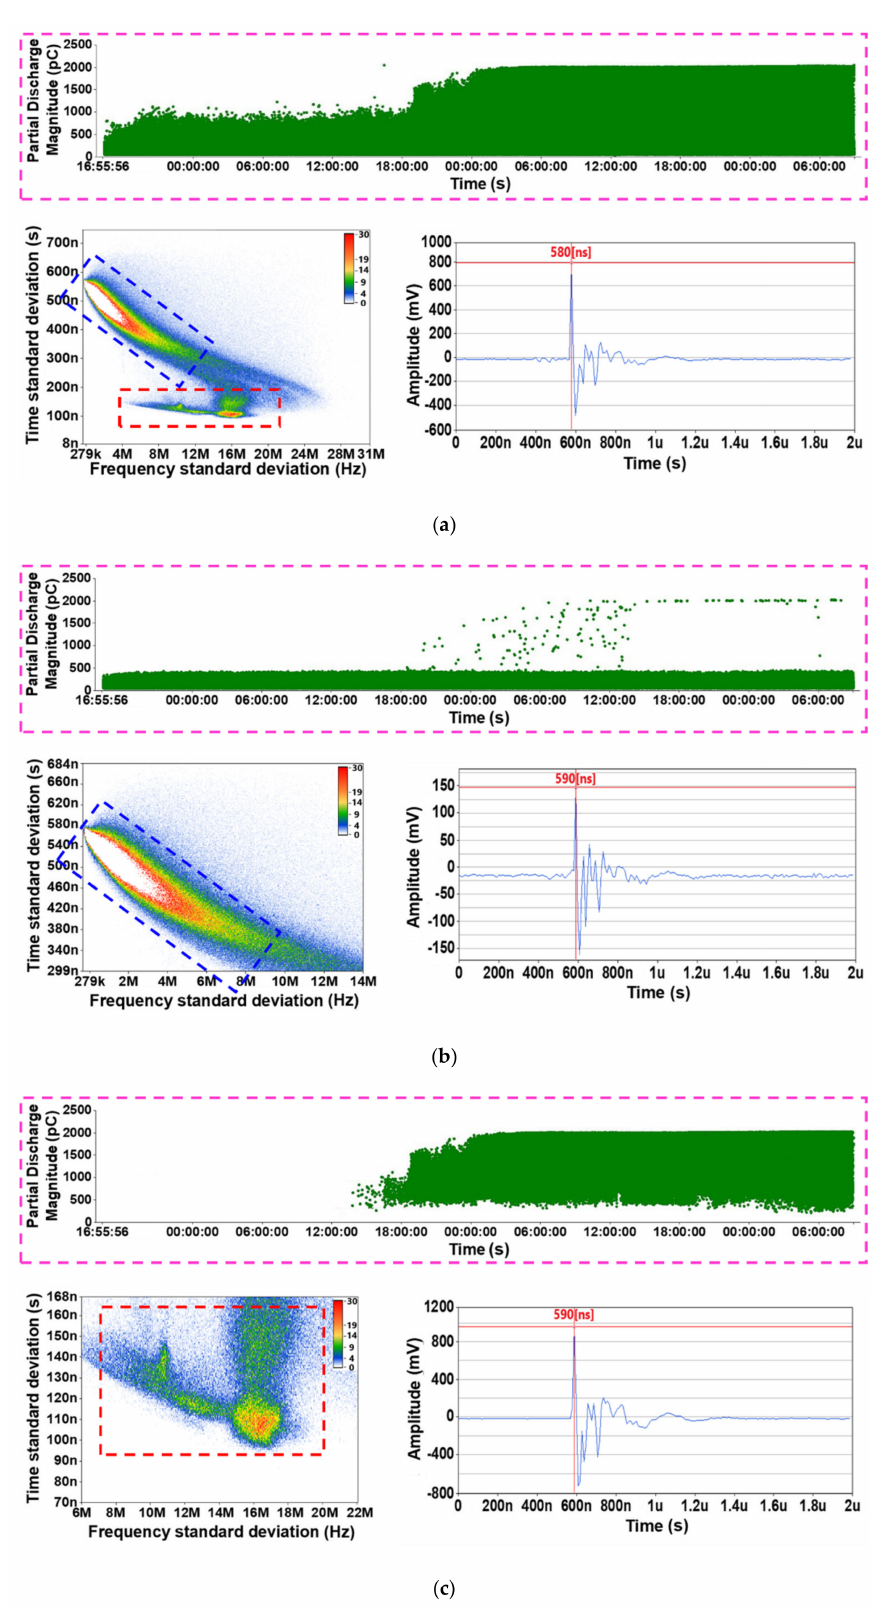
Figure 9. The measurement results of DC void discharge according to the long-term insulation aging: ( a ) measurement results of long-term DC void discharge; ( b ) measurement results of DC void discharge classified through time-frequency (TF) mapping; ( c ) measurement results of DC void discharge due to the insulation aging classified through TF